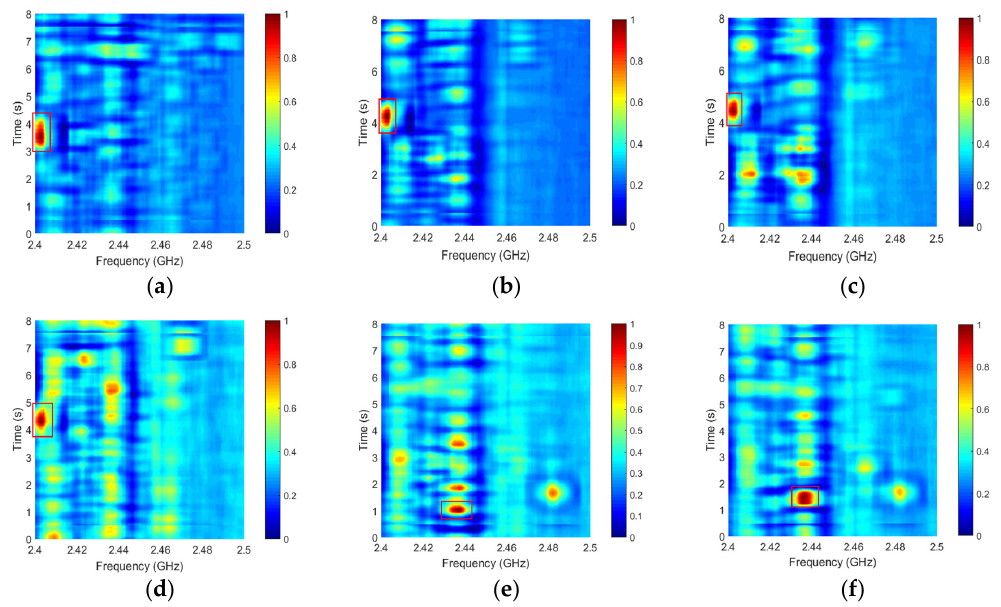
Figure 12. The results for the constant false alarm rate (CFAR) method outdoors at distances of ( a ) 500 m, ( b ) 1000 m, ( c ) 1500 m, ( d ) 2000 m, ( e ) 2500 m, and ( f ) 3000 m.